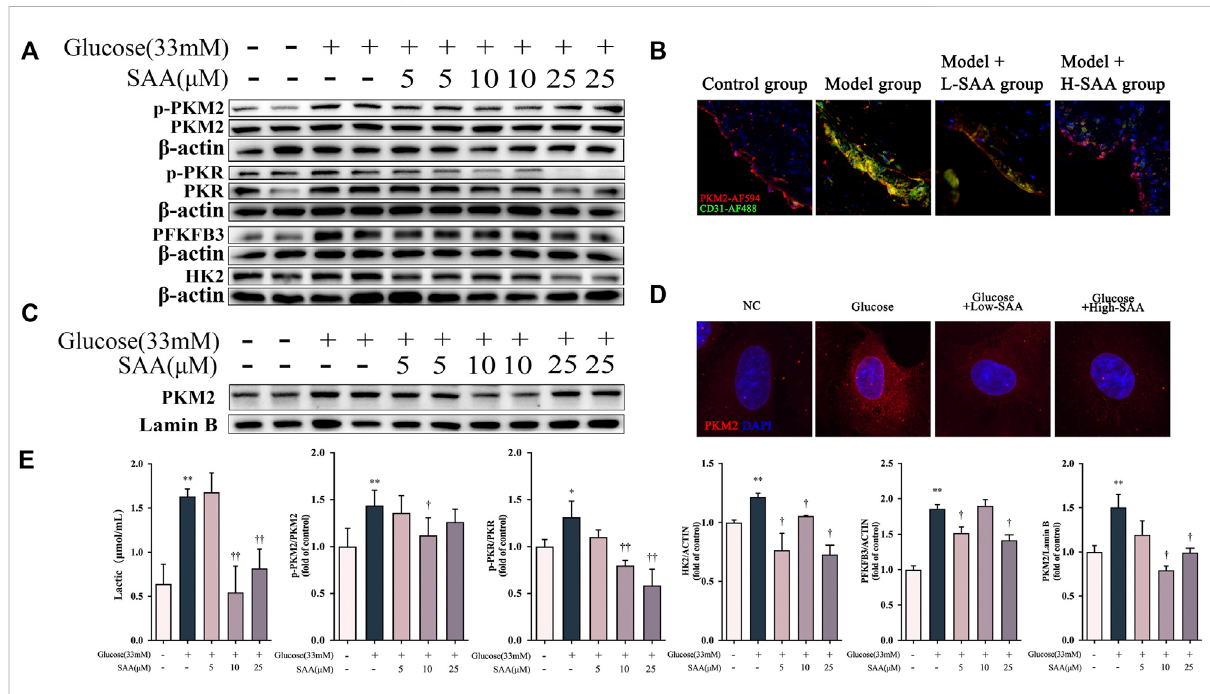
SAA Down-regulated PKM2/PKR pathway in high glucose-stimulated HUVECs. (A) Expression levels of pPKM2, pPKR, PKM2, PKR, HK2, PFKFB3 and ß -Actin in HUVECs weredetermined bywestern blot. (B) pPKM2 and CD31 levels inaortic roots were detected byimmuno fl uorescence (C) CellularlocalizationofPKM2wasanalyzedbyimmuno fl uorescencestaining. (D) NuclearfractionswereisolatedandPKM2levelsinHUVECswere detected by Western blotting. (E) Lactate levels in HUVECs. Data of western blotare therepresentatives of four independentexperiments. Date of histograms are represented as mean ± SD of three independent experiments. * p < 0.05, ** p < 0.01 vs. control group. † p < 0.05, †† p < 0.01 vs. high glucose